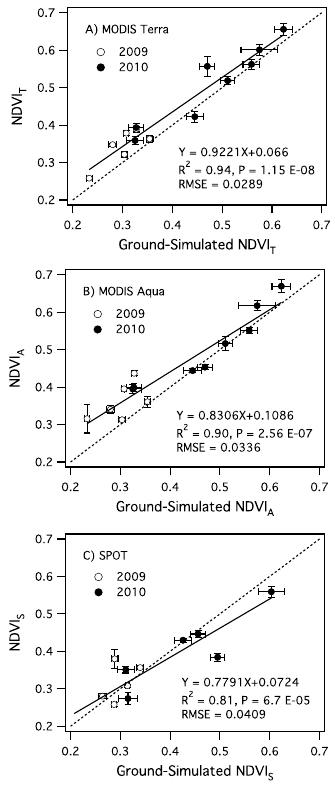
Figure 9. Ground-simulated NDVI vs. satellite NDVI for MODIS Terra ( A ); MODIS Aqua ( B ); and SPOT ( C ). Data from 2009 and 2010 are distinguished by different symbols, as indicated on each panel. Ground-simulated NDVI was derived using MODIS or SPOT band passes, as described in Section 2. Also shown are the 1:1 lines (dotted lines) and the best-fit regression lines (solid lines) for each comparison, along with regression equations, relevant statistics, and RMSE values. Error bars indicate the standard error of the mean.